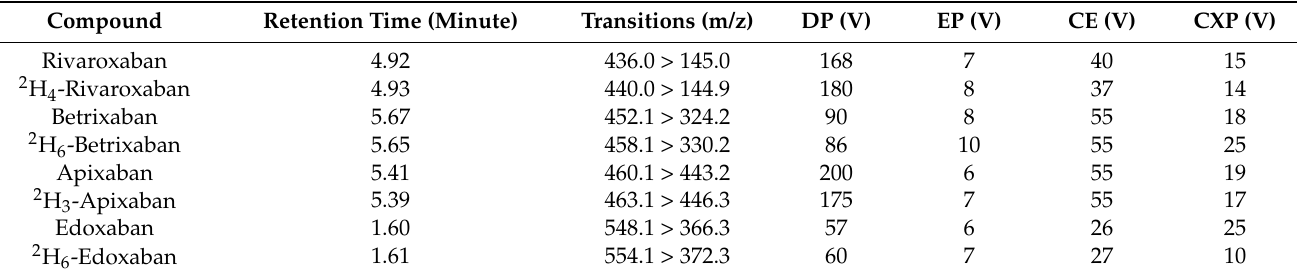
Figure 1. Typical extracted ion chromatograms of a processed blank plasma spiked with 50 ng/mL of selected DOACs ( a ) and their internal standards ( b ) on BEH C 18 , BEH Phenyl ( c ), and CSH C 18 ( d ) columns under optimized conditions. Table 1. Optimized transitions parameters for all